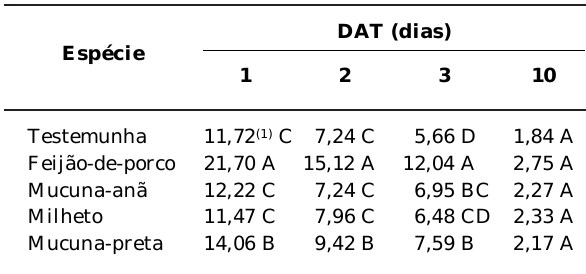
Quadro 2. Valores médios de taxa de evolução de CO em solo rizosférico de quatro espécies e 2 uma testemunha não-rizosférica, em quatro épocas de